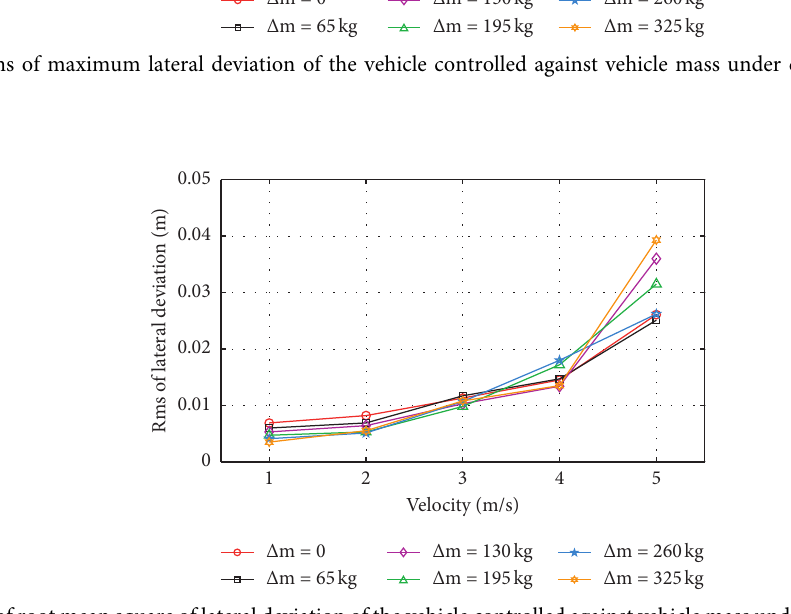
Figure 9: Variations of root mean square of lateral deviation of the vehicle controlled against vehicle mass under different vehicle